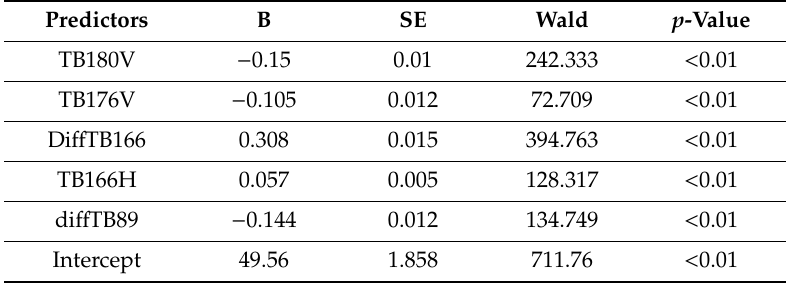
Table 6. Final logistic regression model results after the stepwise selection was applied to all high frequency channel TBs at 89 GHz and above and the vertical and horizontal brightness temperature coe ffi cients, “SE” indicates the standard error and “Wald” indicates the observed Wald test statistic.